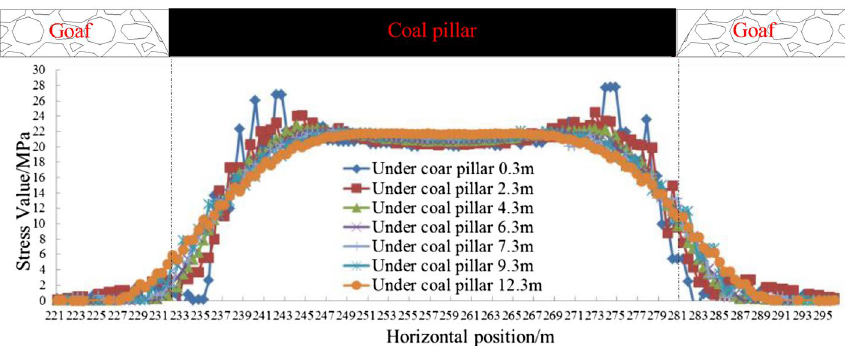
Figure 5. Stress change under coal pillar 0.3 m to 12.3 m.